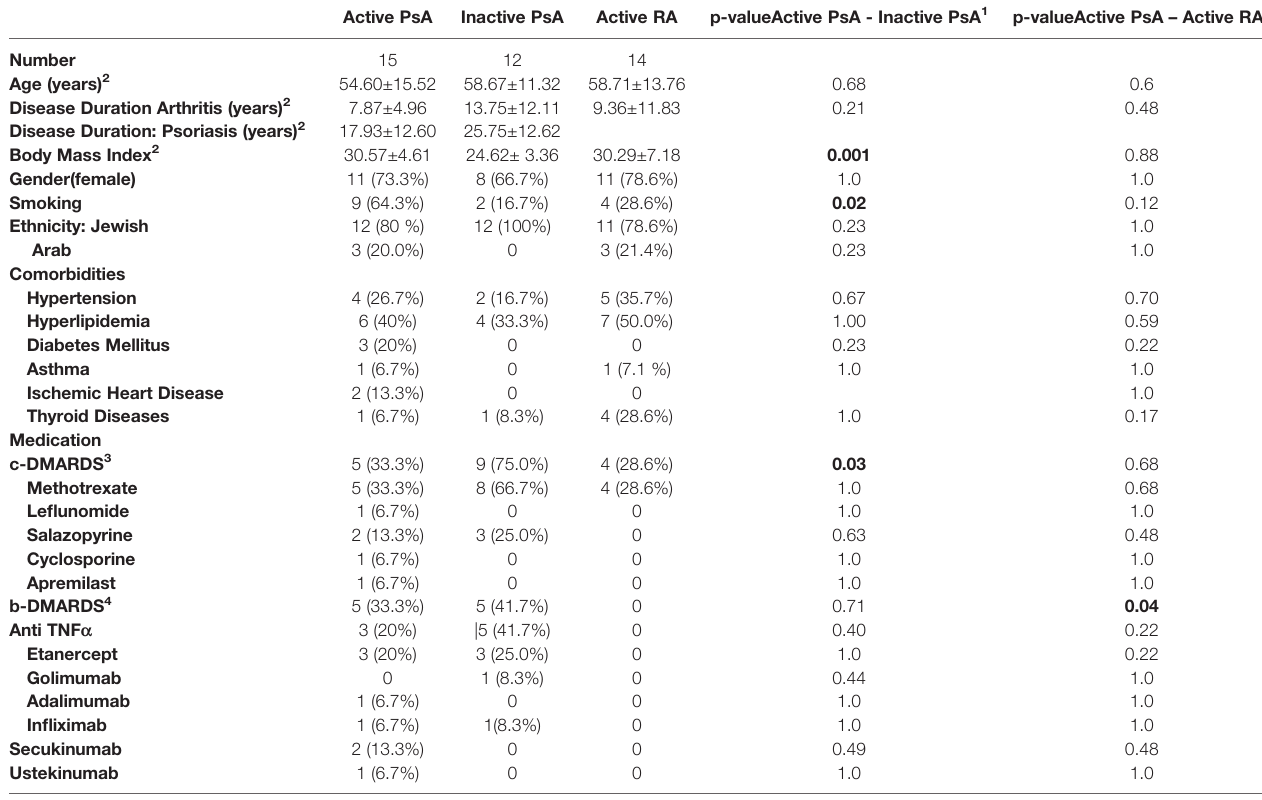
TABLE 1 | Characteristics of the study patient